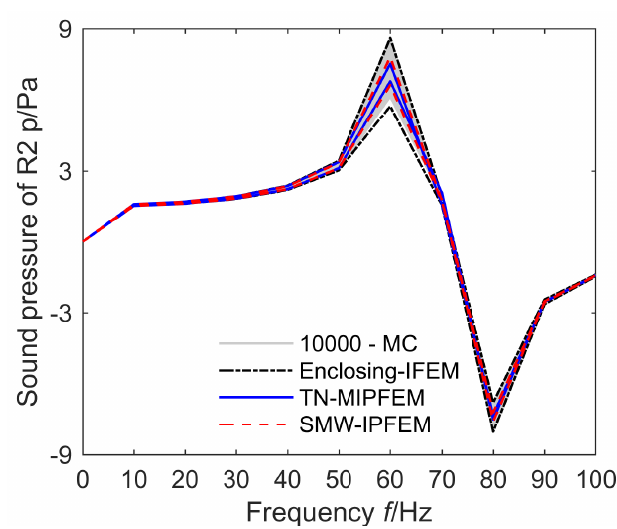
Figure 8. The sound pressure at the point of R1.